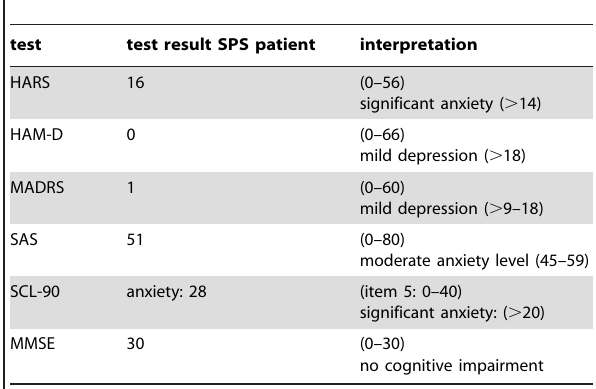
Table 1. Neuropsychological evaluation of the SPS patient.